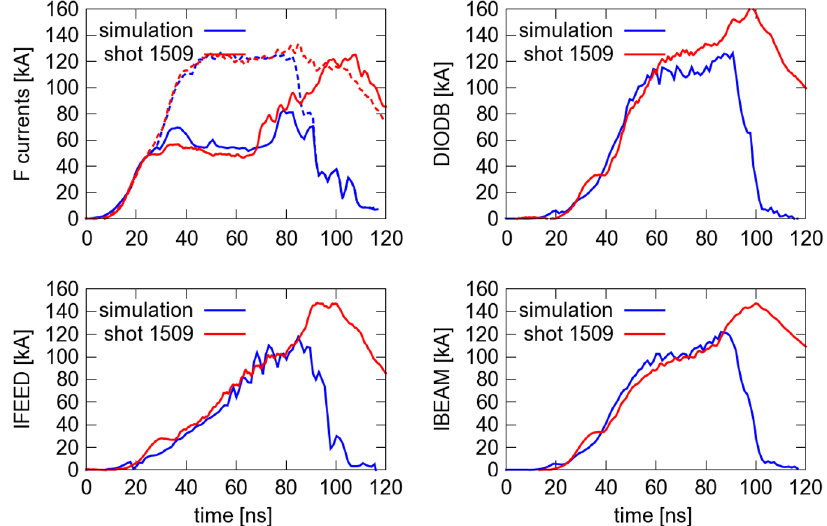
FIG. 8. Currents in the MITL, dustbin, and diode from a simulation of shot 1509 compared to data. The diode has a 7-mm diameter needle and a 7-mm AK gap. The falling diode impedance is modeled using massive fluid electrons at the anode which drift away from the surface and effectively reduce the AK